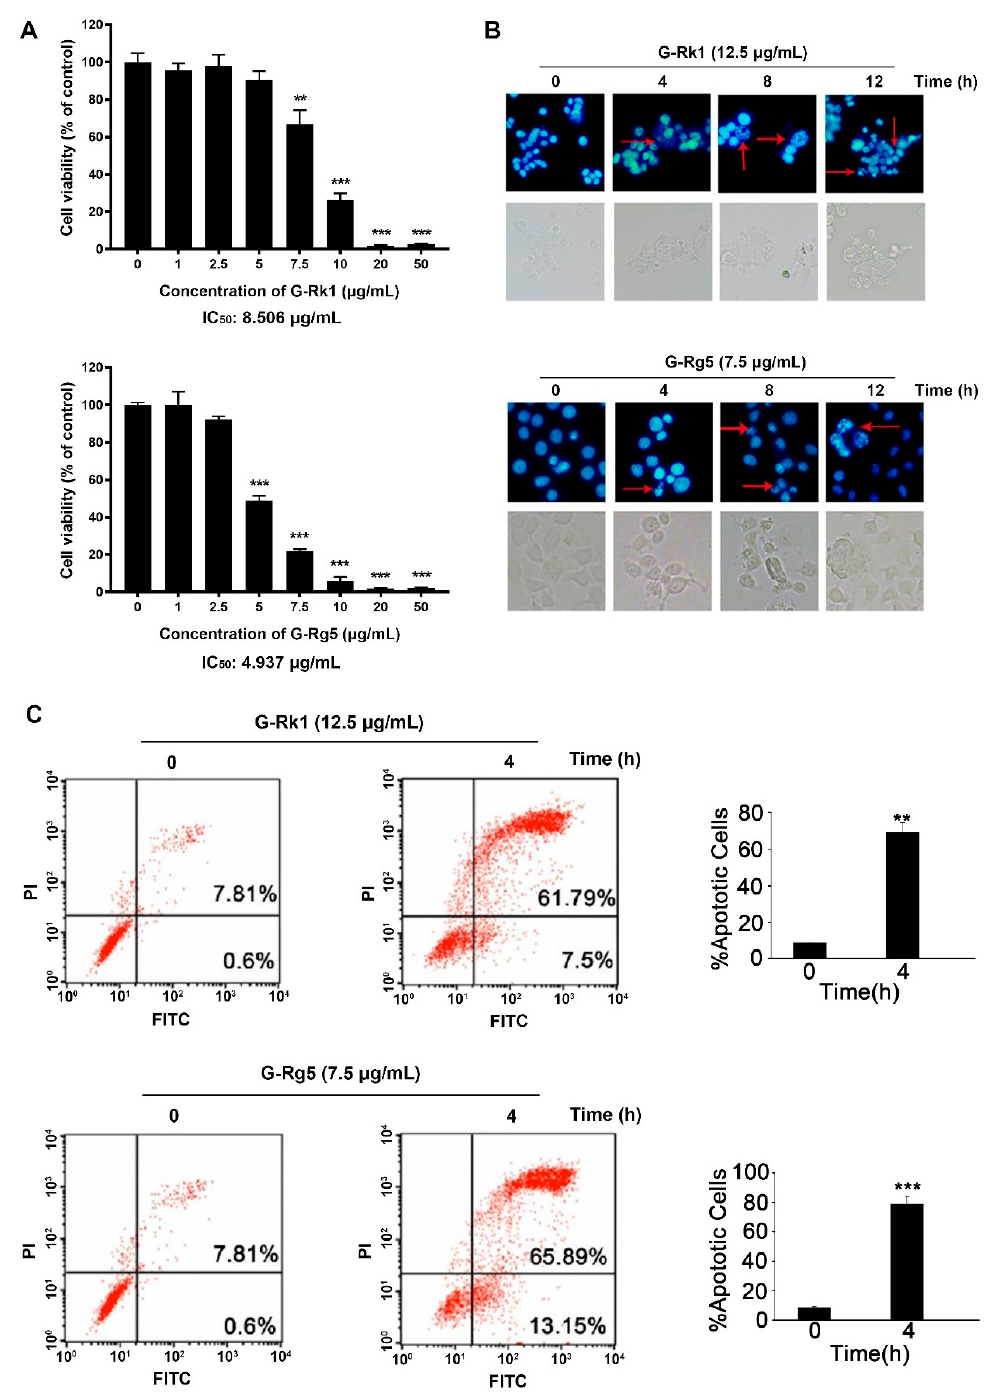
Figure 2. Cytotoxic effect of G-Rk1 and G-Rg5 on MHCC-97H cells. ( A ) MHCC-97H cells were treated with various concentrations of G-Rk1 or G-Rg5 for 48 h. Cell viability was determined by MTT assay. ( B ) MHCC-97H cells were treated with 12.5 μ g/mL G-Rk1 or 7.5 μ g/mL G-Rg5 for the indicated times. The cells were stained with DAPI to visualize the morphological changes under a fluorescence microscope. The red arrows indicate chromatin condensation. ( C ) MHCC-97H cells were treated with G-Rk1 or G-Rg5 for 0 h or 4 h. The cells were stained with Annexin V-FITC/PI, and the degree of apoptosis was determined by measuring the population of Annexin V-FITC/PI-positive cells by flow cytometry. All data are shown as the mean ± SD of experiments performed in triplicate. A Student’s t -test was used for quantitative analysis with *** presenting p < 0.001 and ** presenting p < 0.01.